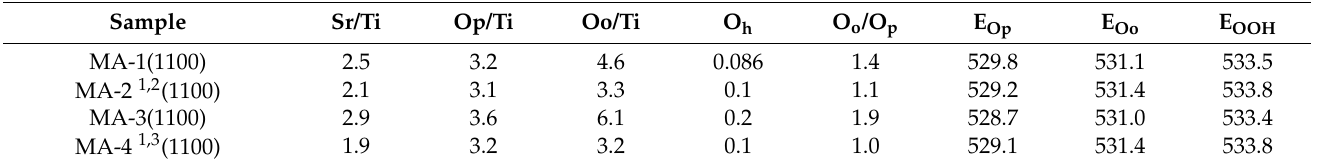
Figure 11. XPS spectra O 1s and Sr 3d of the samples calcined at 1100 ◦ C: 1—MA-1, 2—MA-2, 3—MA-3 and 4—MA-4. Table 2. Atomic ratio of elements in the surface layers and binding energy of oxygen in the different states for the samples calcined at 900–1100 ◦ C obtained from XPS